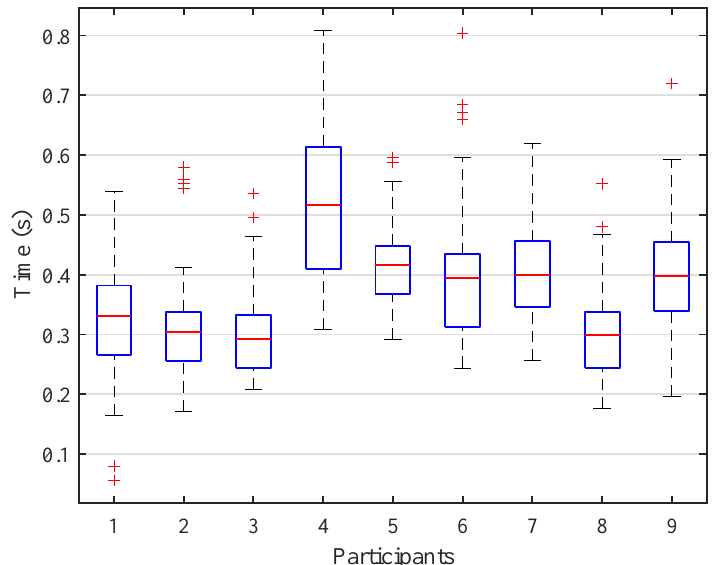
Figure 10. Box plot of the reaction times for all the blinks performed by the subjects across all the blinking experiments. On each box, the average response time is marked as the central red line and the bottom and top edges of the box indicate the 25th and 75th percentiles, respectively. The whiskers extend to the maximum and minimum reaction time not considered as outliers. The outliers are individually plotted using the ‘+’ symbol.